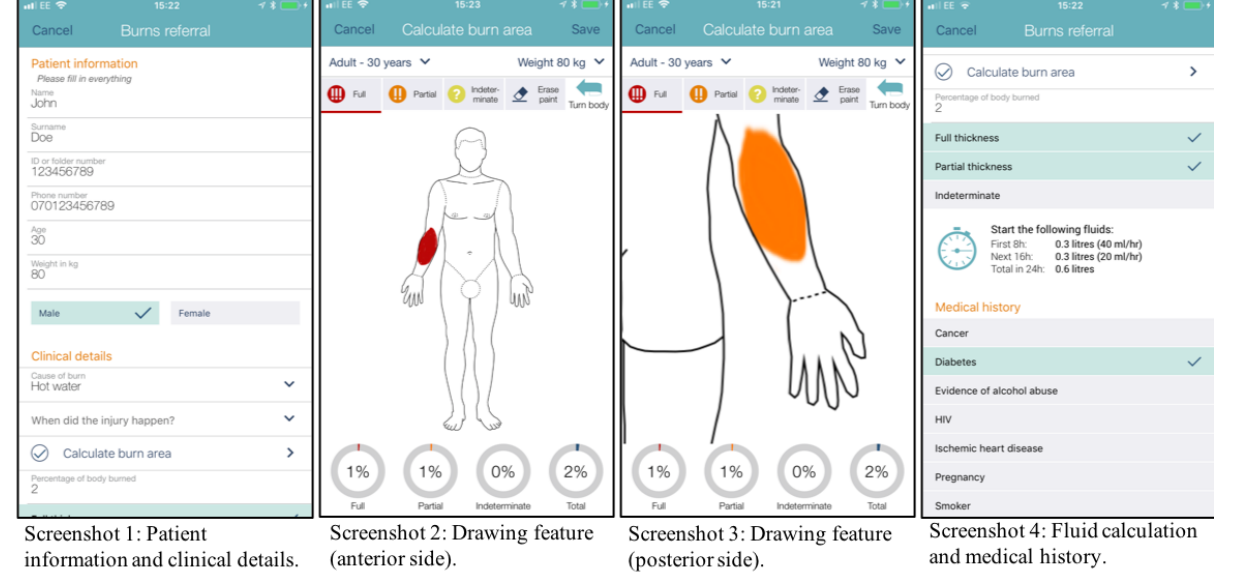
Figure 1. Screenshots of the user interface of the Vula app for burn injury consultations and